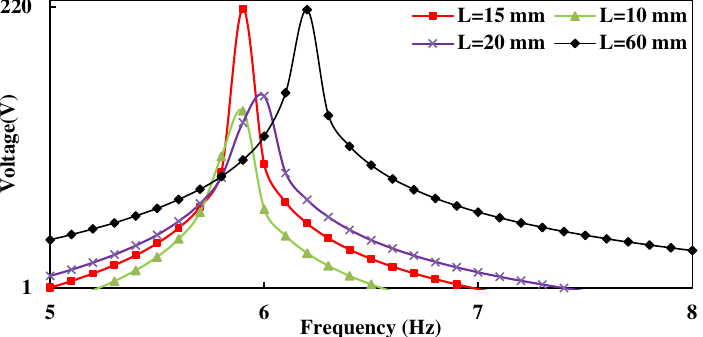
Figure 10. The effect of the PZT length on the output voltage and bandwidth natural frequency.